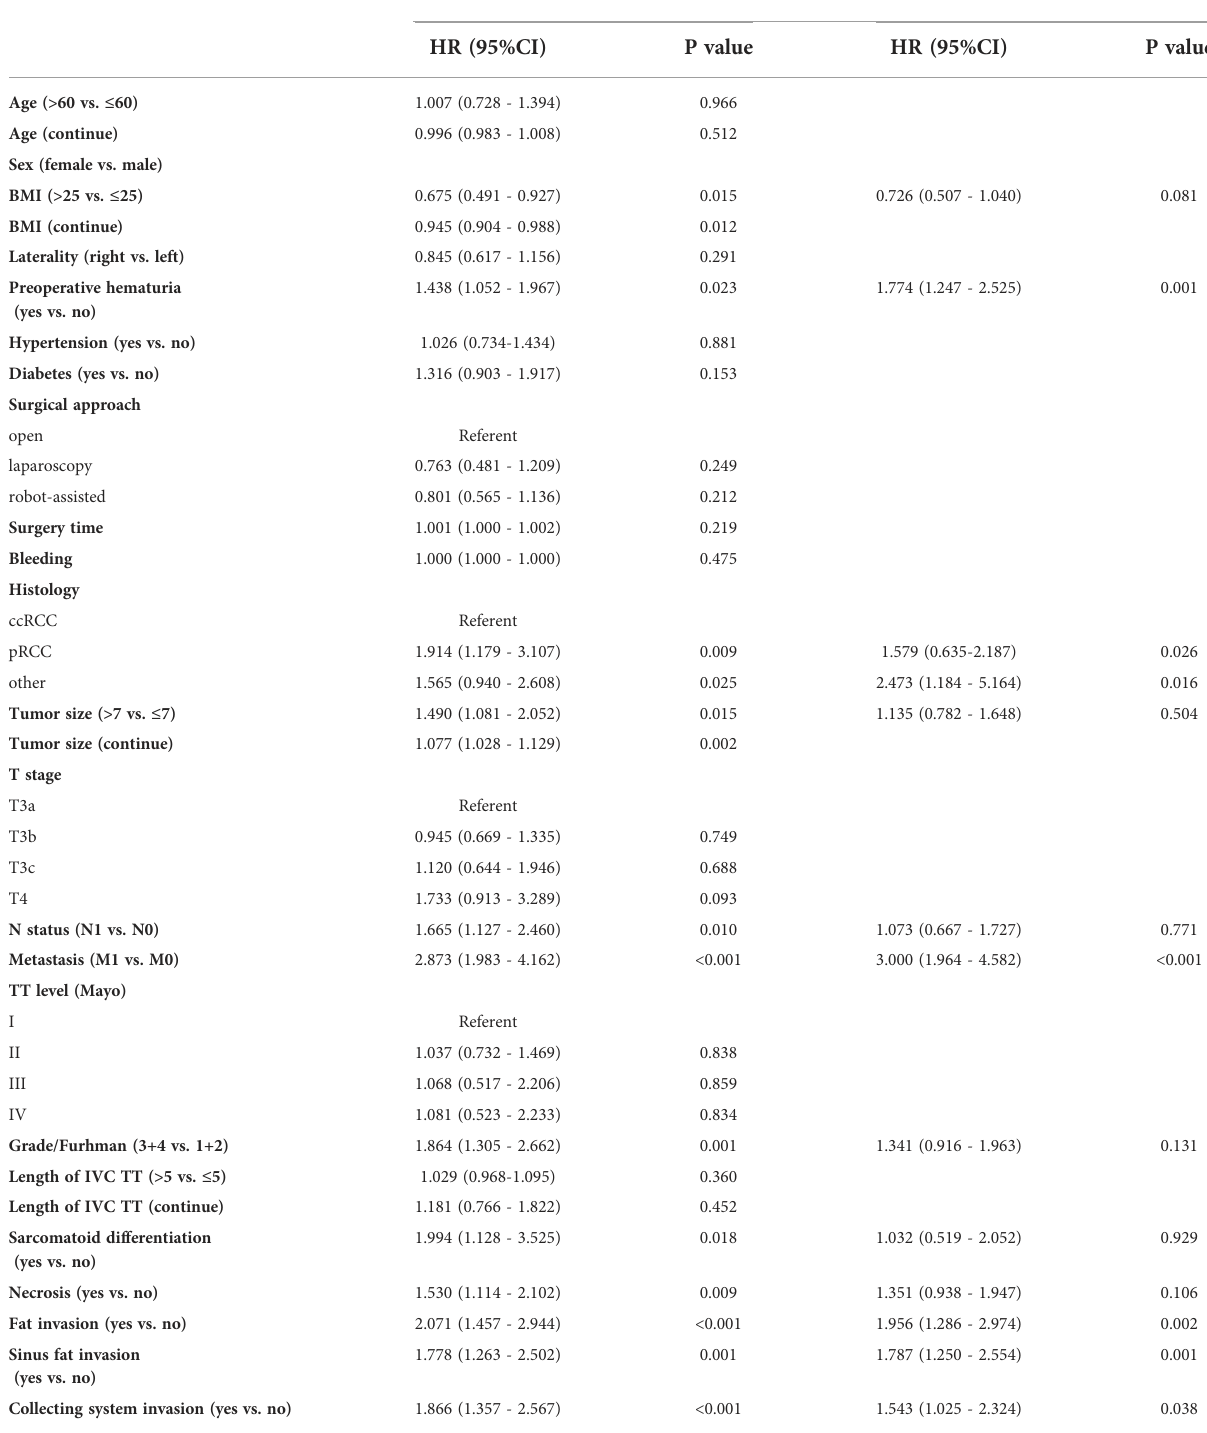
TABLE 2 Univariable and multivariate Cox proportional hazards regression for overall